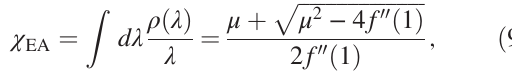
ffiffiffiffiffiffiffiffiffiffiffi p f 00 ð 1 Þ